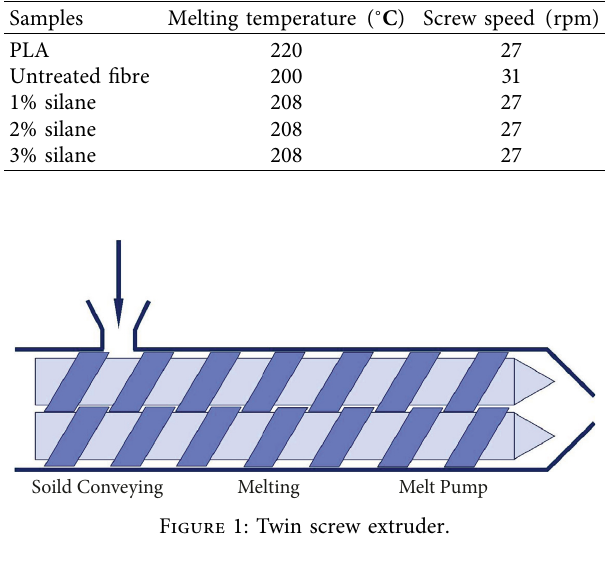
Table 4: Extrusion-related constraint.